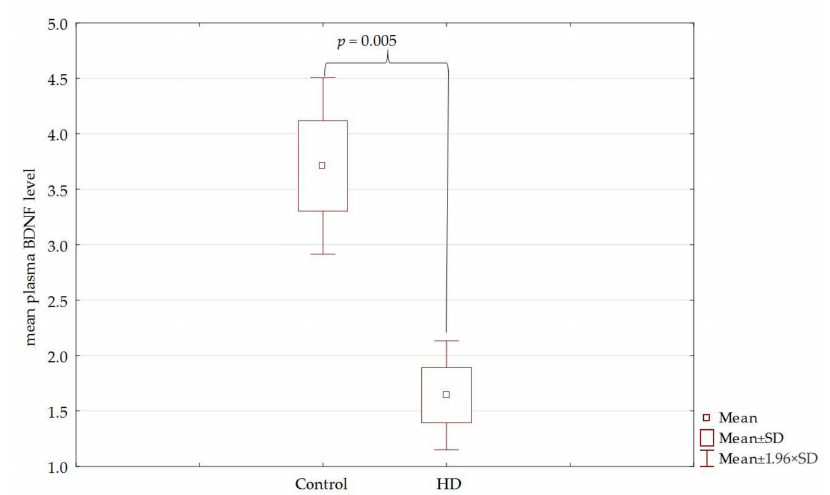
Figure 1. Plasma levels of BDNF in control and patients with